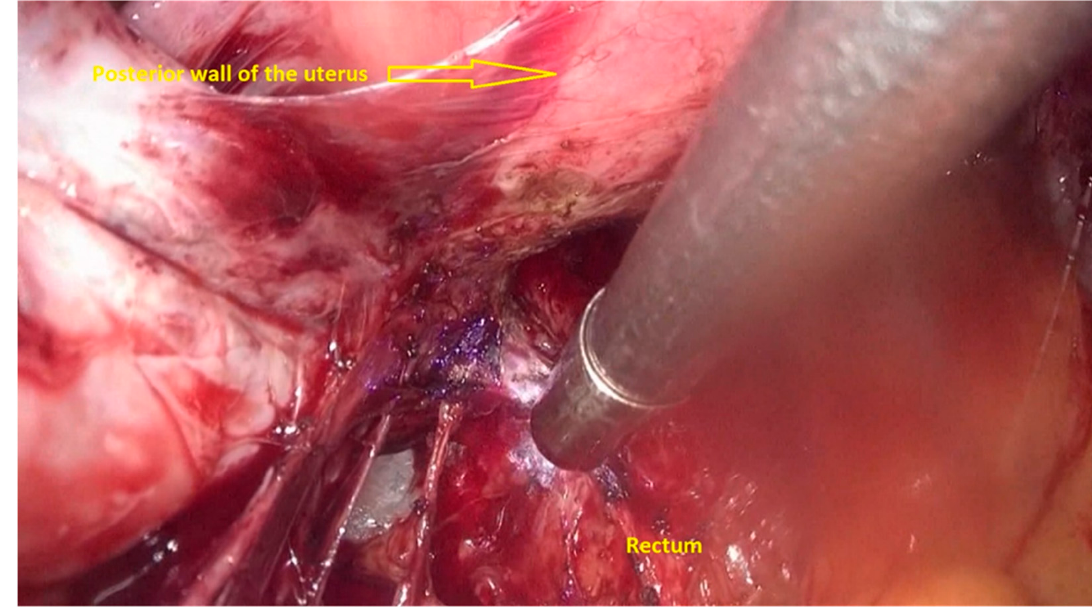
Figure 3. Opening the deep rectal spaces and rectovaginal septum surrounding the rectal nodule. The nodule is dissected, and the rectum is released and shaved.